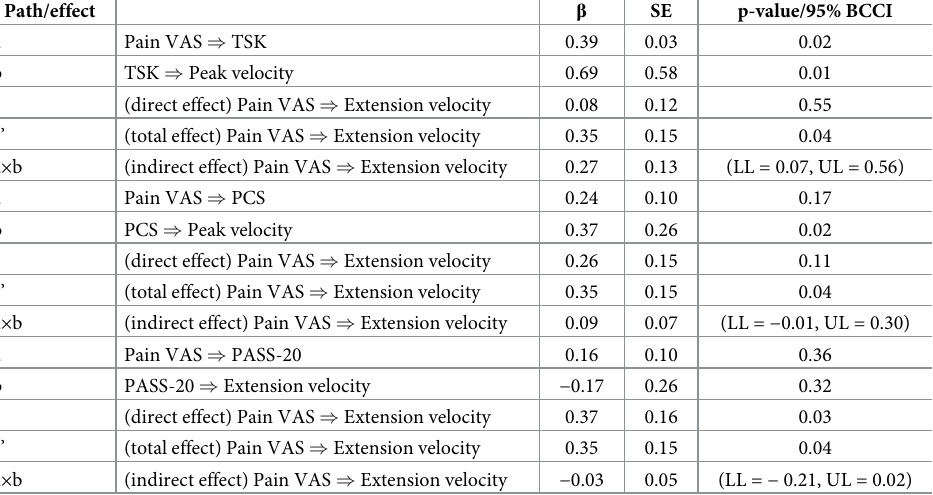
Table 5. The results of the mediation analysis.